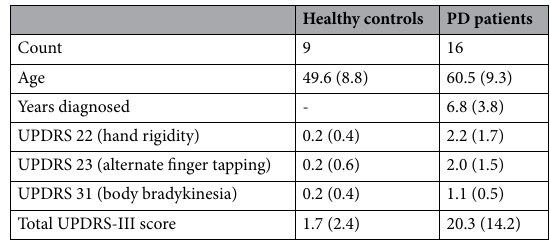
Table 4. Clinically-assessed subjects that contributed typing data. All values (except count) refer to the population mean, with the standard deviation given inside